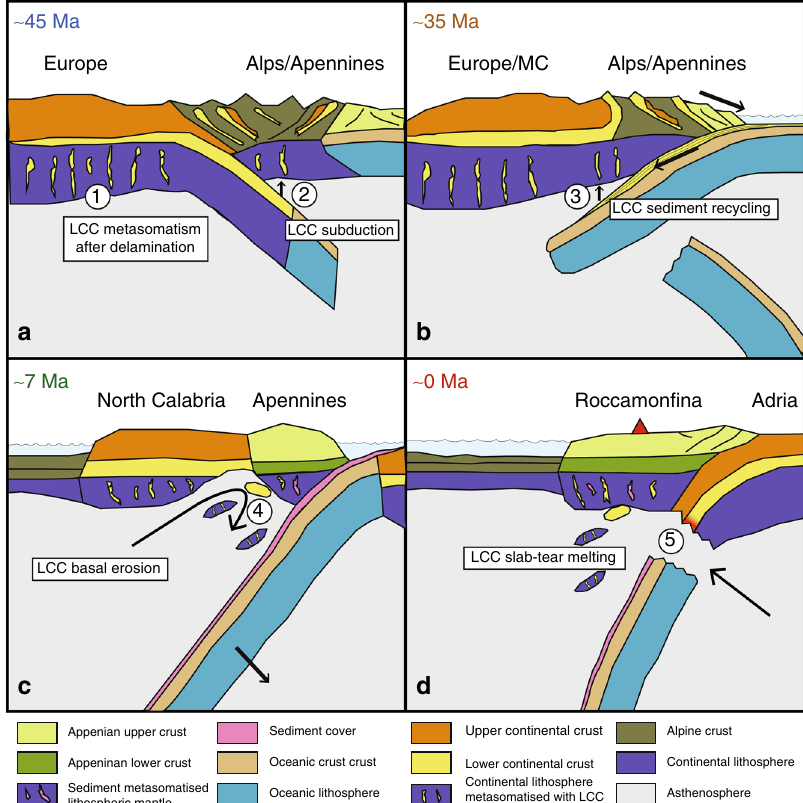
Fig. 5 Provenance of the lower continental crust (LCC) in a geodynamic context. Schematic cross-sections illustrate potential geodynamic processes that resulted in the emplacement of a LCC component that we infer to be present in the Roccamon fi na-Ernicic melt source. a Lithosphere and LCC delamination after the Variscan Orogeny below Europe and the Massif Central (MC) led to metasomatism with a LCC imprint (scenario 1). Alternatively, European LCC subducted during the onset of the Alpine collision before subduction reversal between 45 and 35 Ma (scenario 2). b Subduction recycling of sediments from exhumed lower crustal blocks in the hinterland during and after the Alpine Orogeny (scenario 3). c Accelerated roll-back along a transform or slab- tear fault results in thermo-mechanical erosion of the base of Calabria between 8 – 6 Ma (scenario 4). d Slab tear and in fl ow of hot asthenosphere results in melting of Adriatic LCC (scenario 5). Note that although Variscan LCC is known to occur below Sardinia and in the Tuscan region of the northern Apennines 10 (Fig. 1), there is no evidence for its presence in the Roccamon fi na – Ernici